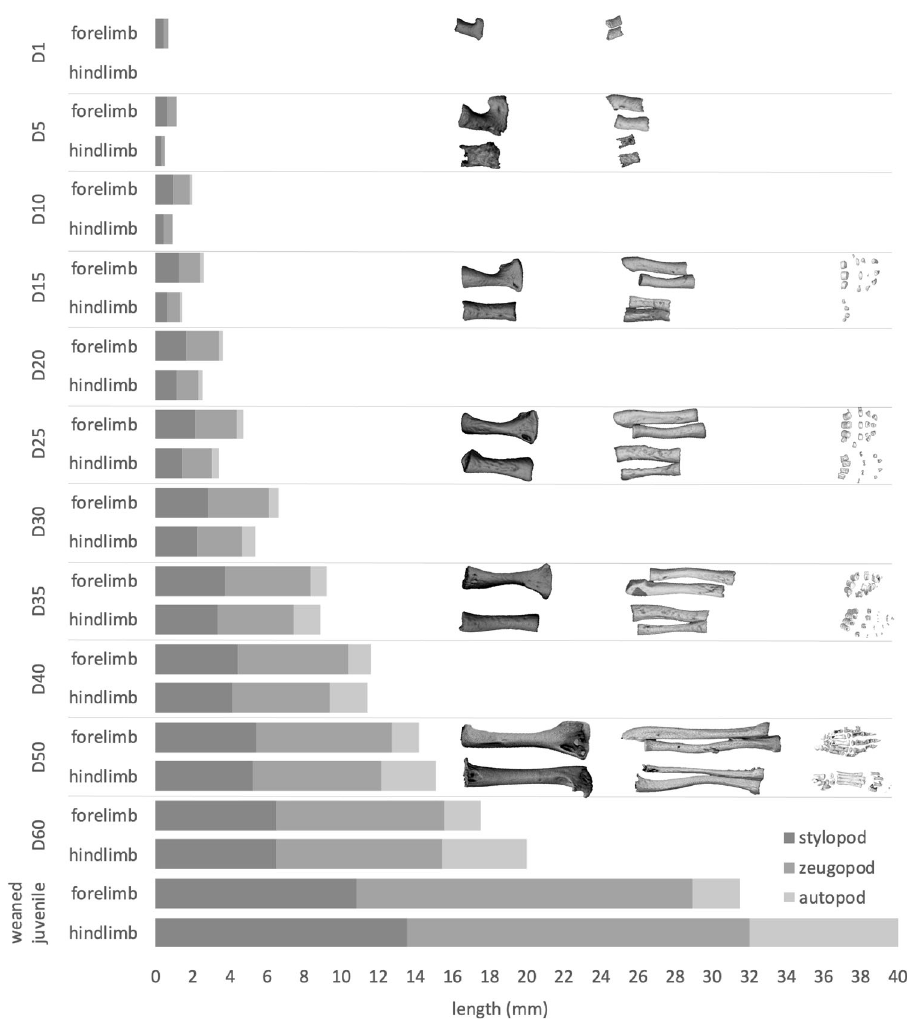
Fig. 8 Limb heterochrony in the fat-tailed dunnart. Relative lengths of forelimb and hindlimb elements throughout development, shown as shaded grey bars ( n = 1). Limbs are divided into proximal and distal segments: the stylopod (humerus and femur), zeugopod (ulna/radius and tibia/ fi bula) and autopod (carpals, metacarpals, tarsal, metatarsals and